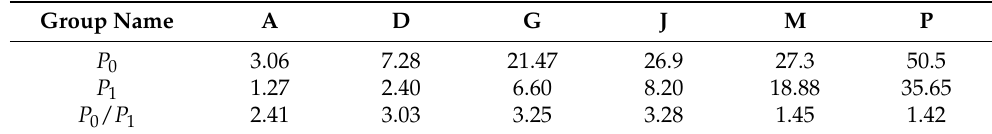
Figure 10. Dynamic pressure at arch vault under the conditions of ( a ) A, D, and G, and ( b ) J, M, and P.